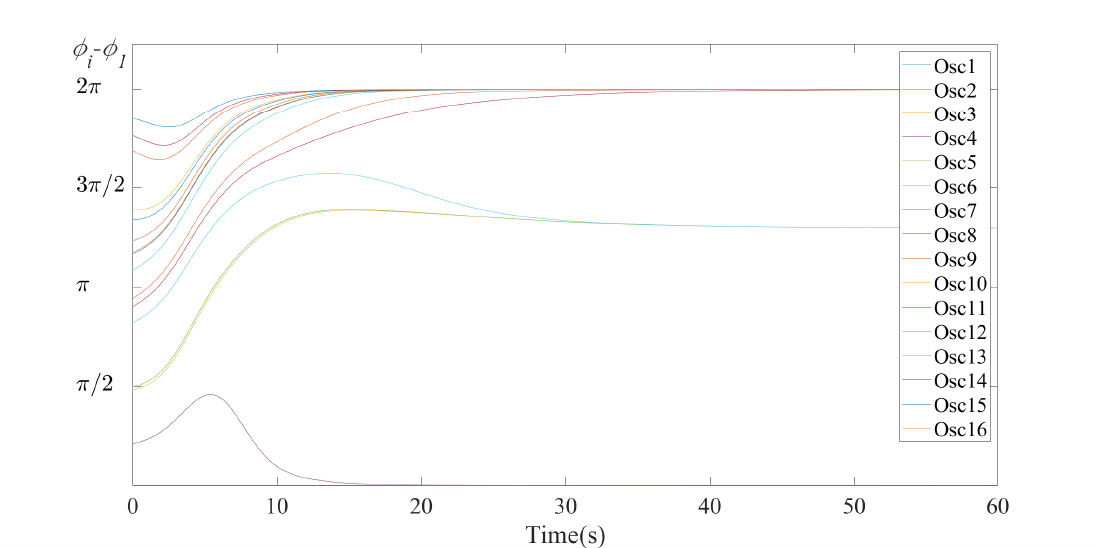
Figure 11. The simulation results are shown as a particular stable 2-cluster partitions, where each curve represents the phase difference φ i − φ j , for i = 1,2,...,16, j = 1, when a 1 = 13, a 2 =